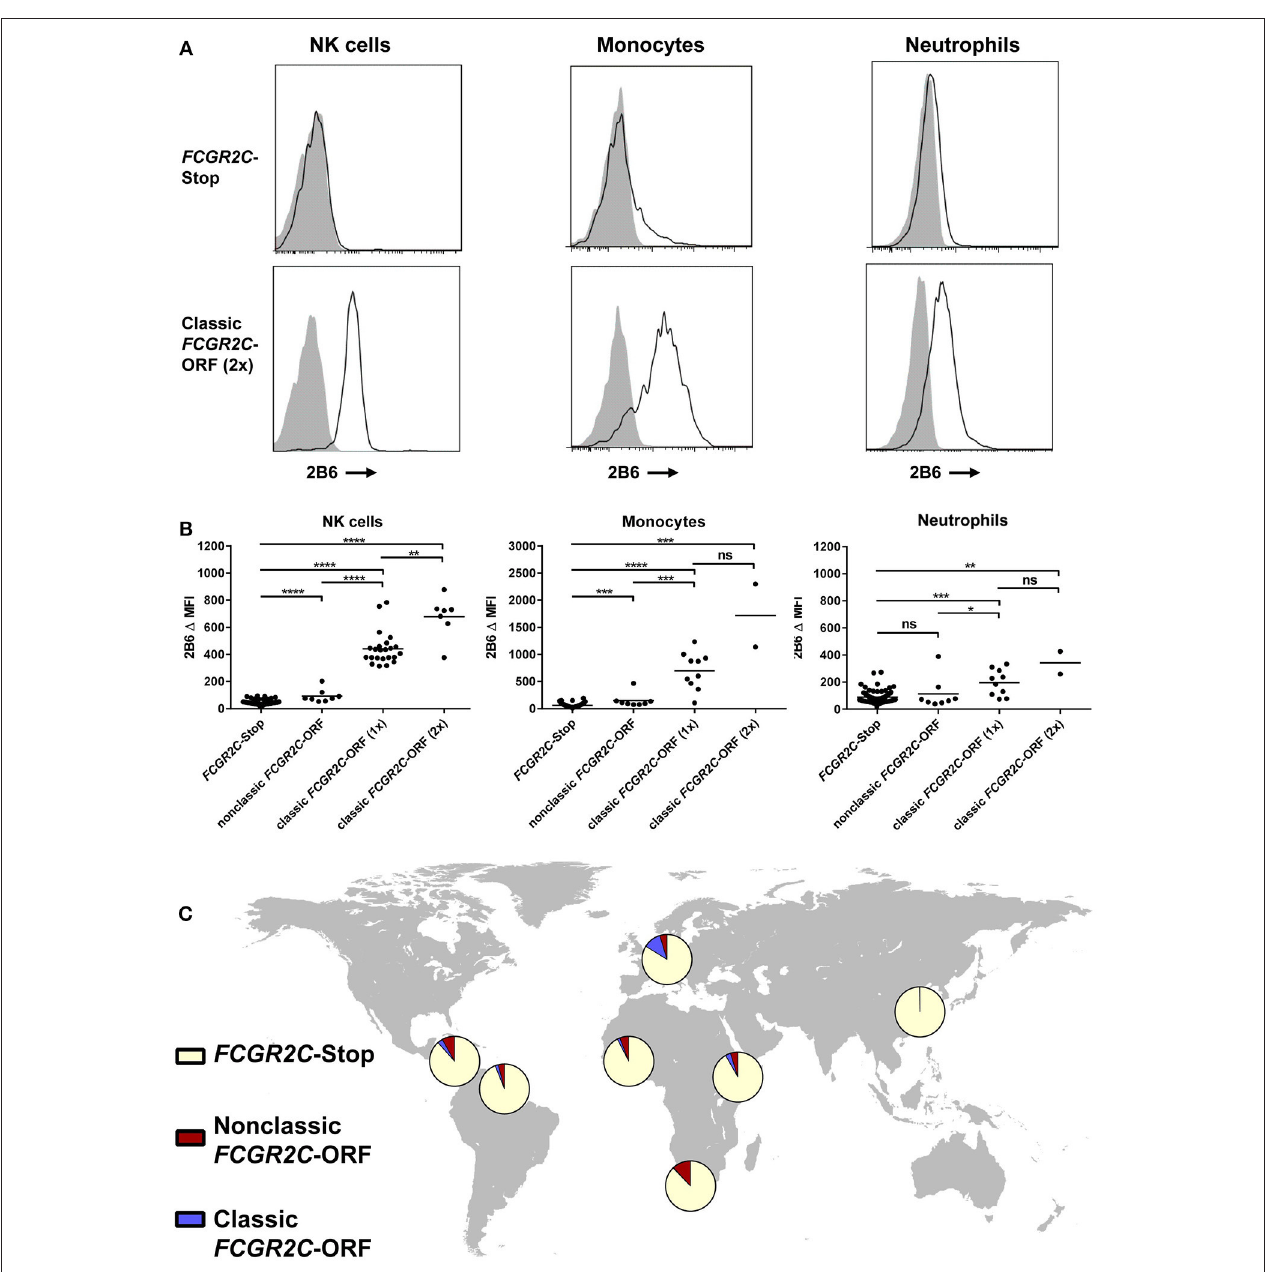
FIGURE 2 | Haplotypes of FCGR2C determine expression of Fc γ RIIc. (A) Representative histograms of staining with MoAb 2B6 on NK cells (left), monocytes (middle), and neutrophils (right) of an individual homozygous for FCGR2C -Stop variant (upper panel) and an individual homozygous for the FCGR2C -ORF variant (lower panel). 2B6 recognizes the extracellular domain of both Fc γ RIIb and Fc γ RIIc. In FCGR2C -Stop individuals, Fc γ RIIc cannot be expressed, therefore staining of 2B6 in those individuals must be Fc γ RIIb only. Black line: 2B6, gray shading: isotype control. (B) Summary of 2B6 staining, corrected for isotype control, on human NK cells (left), monocytes (middle) and neutrophils (right) of genotyped individuals. Y axis scale is different for monocytes than for the other cell types. Because Fc γ RIIb is also stained by 2B6, only cells that do not express Fc γ RIIb can be easily analyzed for Fc γ RIIc expression. Therefore, individuals with a deletion of CNR1 were excluded from the analysis of NK cells, and individuals with a 2B.4 promoter haplotype in FCGR2B were excluded from the analysis of monocytes and neutrophils, because these variants result in ectopic expression of Fc γ RIIb on NK cells (35), or myeloid cells (36), respectively. NK cell analysis: FCGR2C -Stop n = 93, nonclassic FCGR2C -ORF, including cases with 1 or 2 copies n = 8, FCGR2C -ORF(1x), with 1 copy of the classic FCGR2C -ORF haplotype, n = 23, FCGR2C -ORF(2x), with 2 copies n = 7. Monocyte and neutrophil analysis: FCGR2C -Stop n = 99, nonclassic FCGR2C -ORF, including cases with 1 or 2 copies n = 8, FCGR2C -ORF(1x), with 1 copy of the classic FCGR2C -ORF haplotype, n = 10, FCGR2C -ORF(2x), with 2 copies n = 2. Some individuals were analyzed more than once at different time points with similar results; means are shown for these. All individuals analyzed are of European descent except for five FCGR2C -Stop and two nonclassic FCGR2C -ORF individuals who were of African origin. (C) World map showing allele frequencies of FCGR2C haplotypes for different ethnic groups. MFI, median fluorescence intensity; ns, non-significant; * p < 0.05; ** p < 0.01; *** p < 0.001; **** p < 0.0001 as determined by Mann Whitney test.